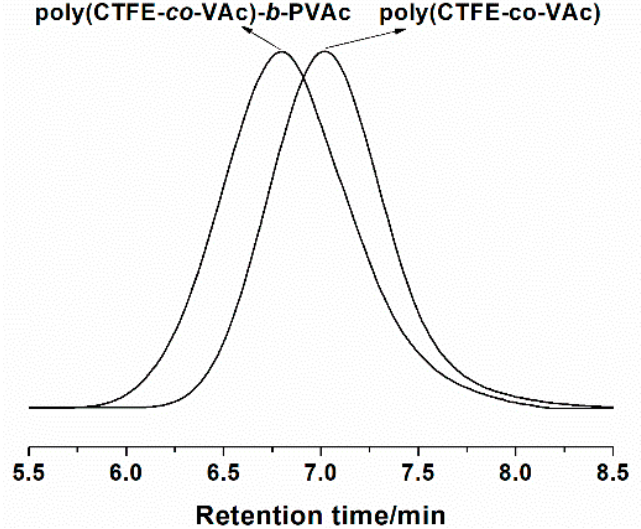
Figure 8. GPC traces of poly(CTFE-co-VAc) (Sample P7, M n,GPC = 19,600, M w / M n = 1.51) and poly(CTFE- co-VAc)- b -PVAc ( M n,GPC = 39,300, M w / M n = 1.57).